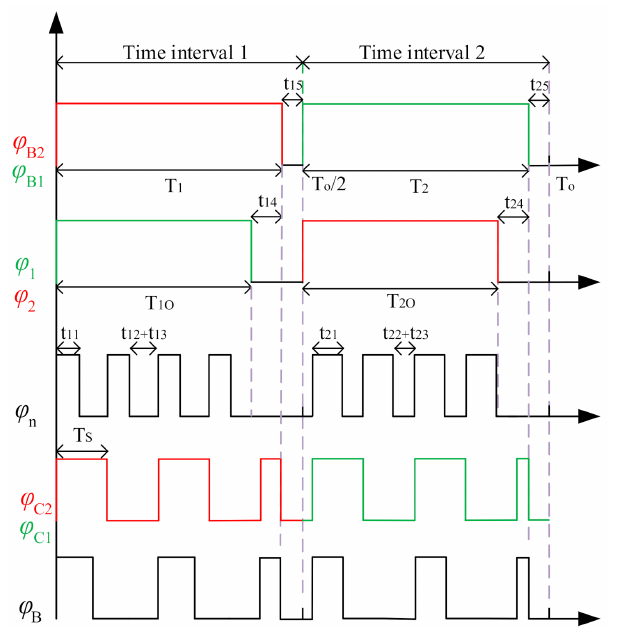
Figure 4. Timing diagram of the proposed single-input multiple-output power supply.